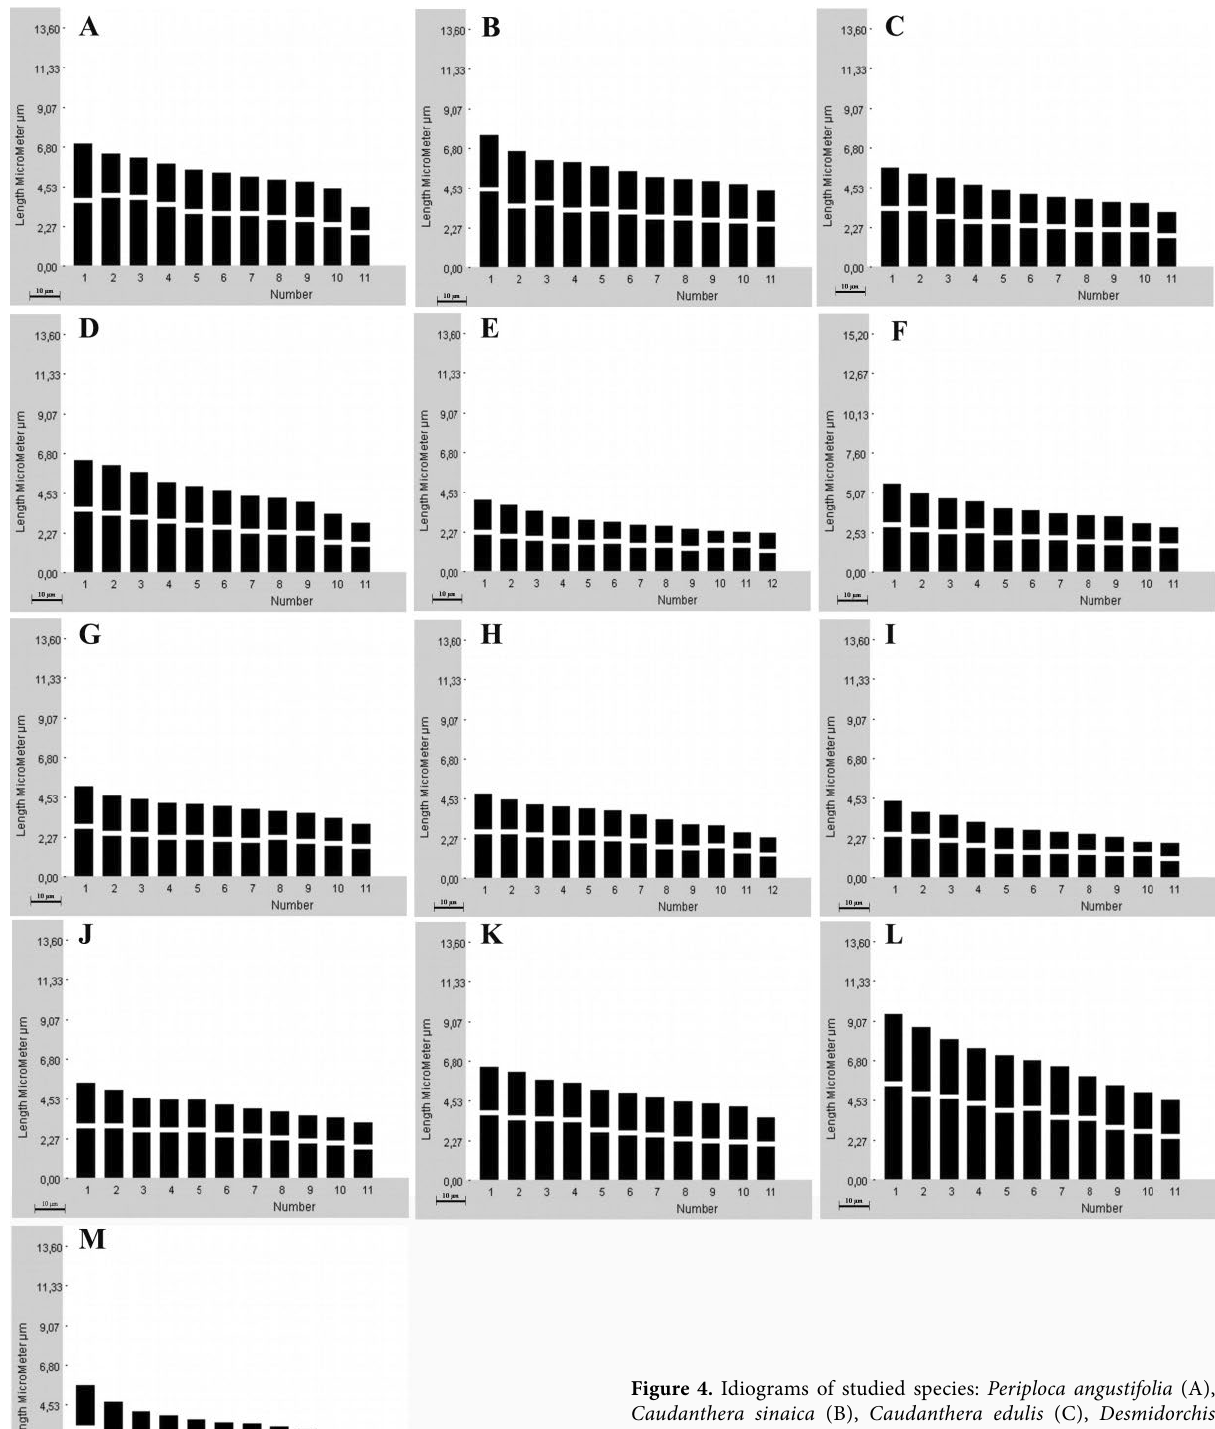
Figure 4. Idiograms of studied species: Periploca angustifolia (A), Caudanthera sinaica (B), Caudanthera edulis (C), Desmidorchis acutangulus (D), Leptadenia arborea (E), Pentatropis nivalis (F), Glossonema boveanum (G), Solenostemma arghel (H), Cynanchum acutum (I), Pergularia tomentosa (J), Pergularia daemia (K), Gom- phocarpus sinaicus (L), Calotropis procera